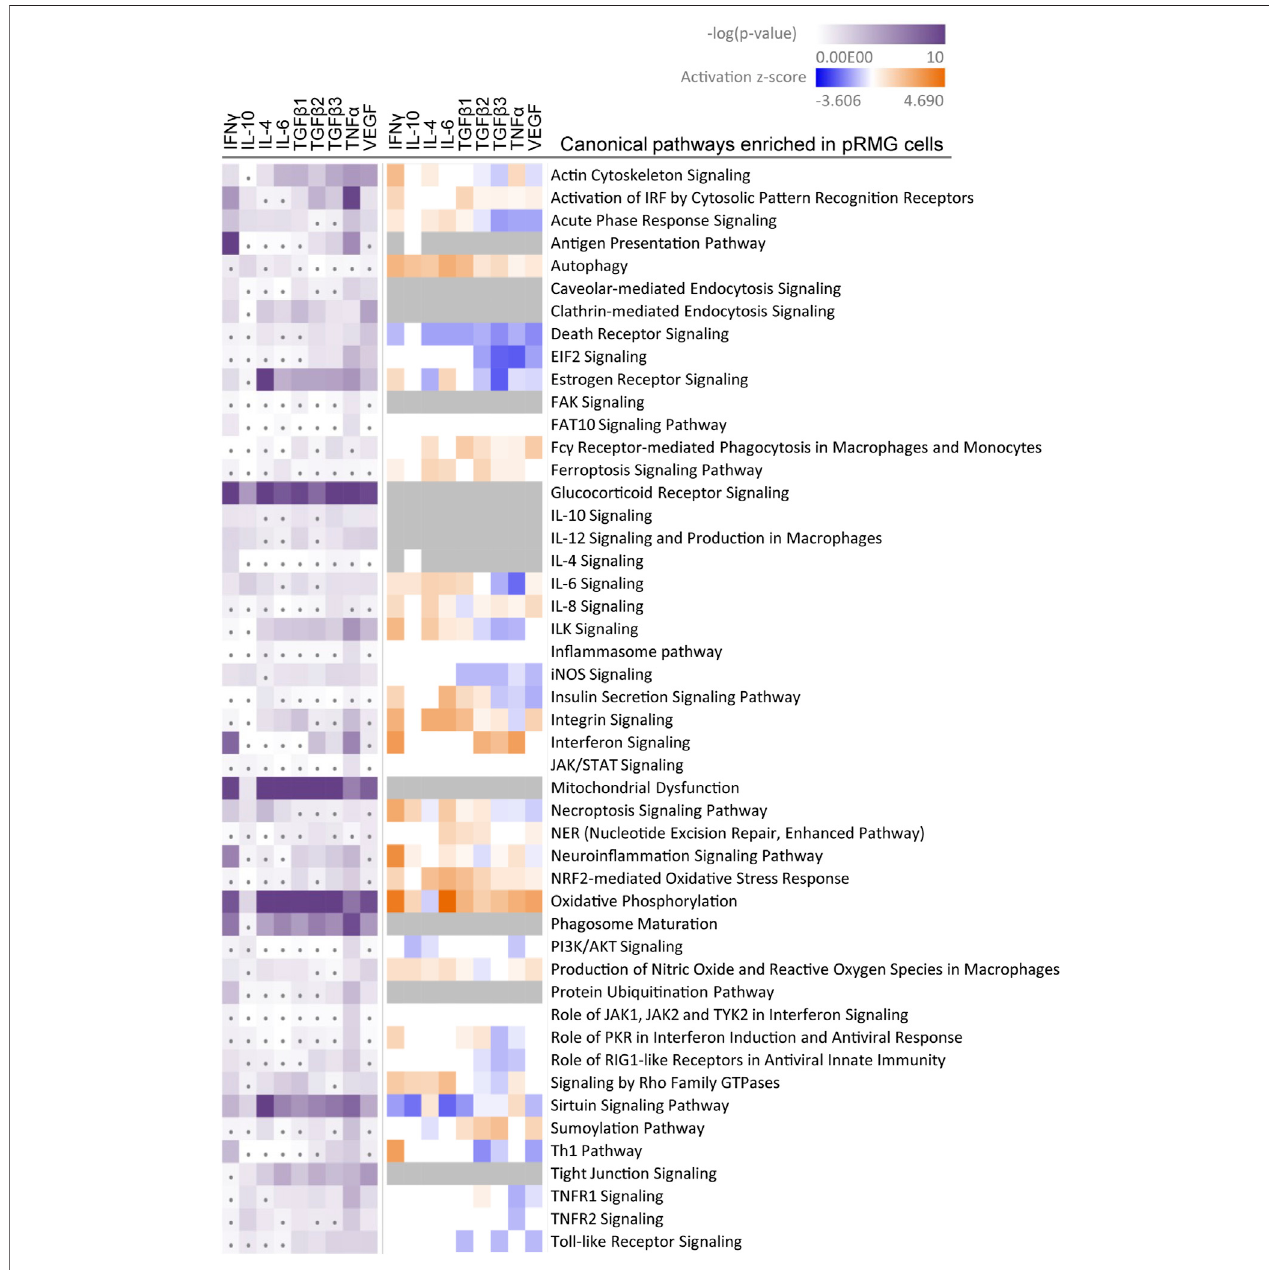
FIGURE 5 | A comparative IPA analysis with the signi fi cantly regulated proteins identi fi ed in the pRMG lysates after stimulation with the indicated cytokines was performed. Canonical pathways related to signaling, cell death, immune system processes and oxidative stress were selected. Pathways with signi fi cant enrichment of genesafterstimulationwithatleastonecytokinearepresented.Signi fi canceofthegeneenrichmentforeachpathwayandtreatmentisindicatedbypurplesquaresinthe left array. Thereby, treatments that did not meet the signi fi cance threshold ( p -value ≤ 0.05) are marked with a dot. The z-score is indicated in the right array and represents a prediction of activation (orange) or inhibition (blue) of the pathway. Gray squares mark treatments where the activation state of a pathway could not be calculated.